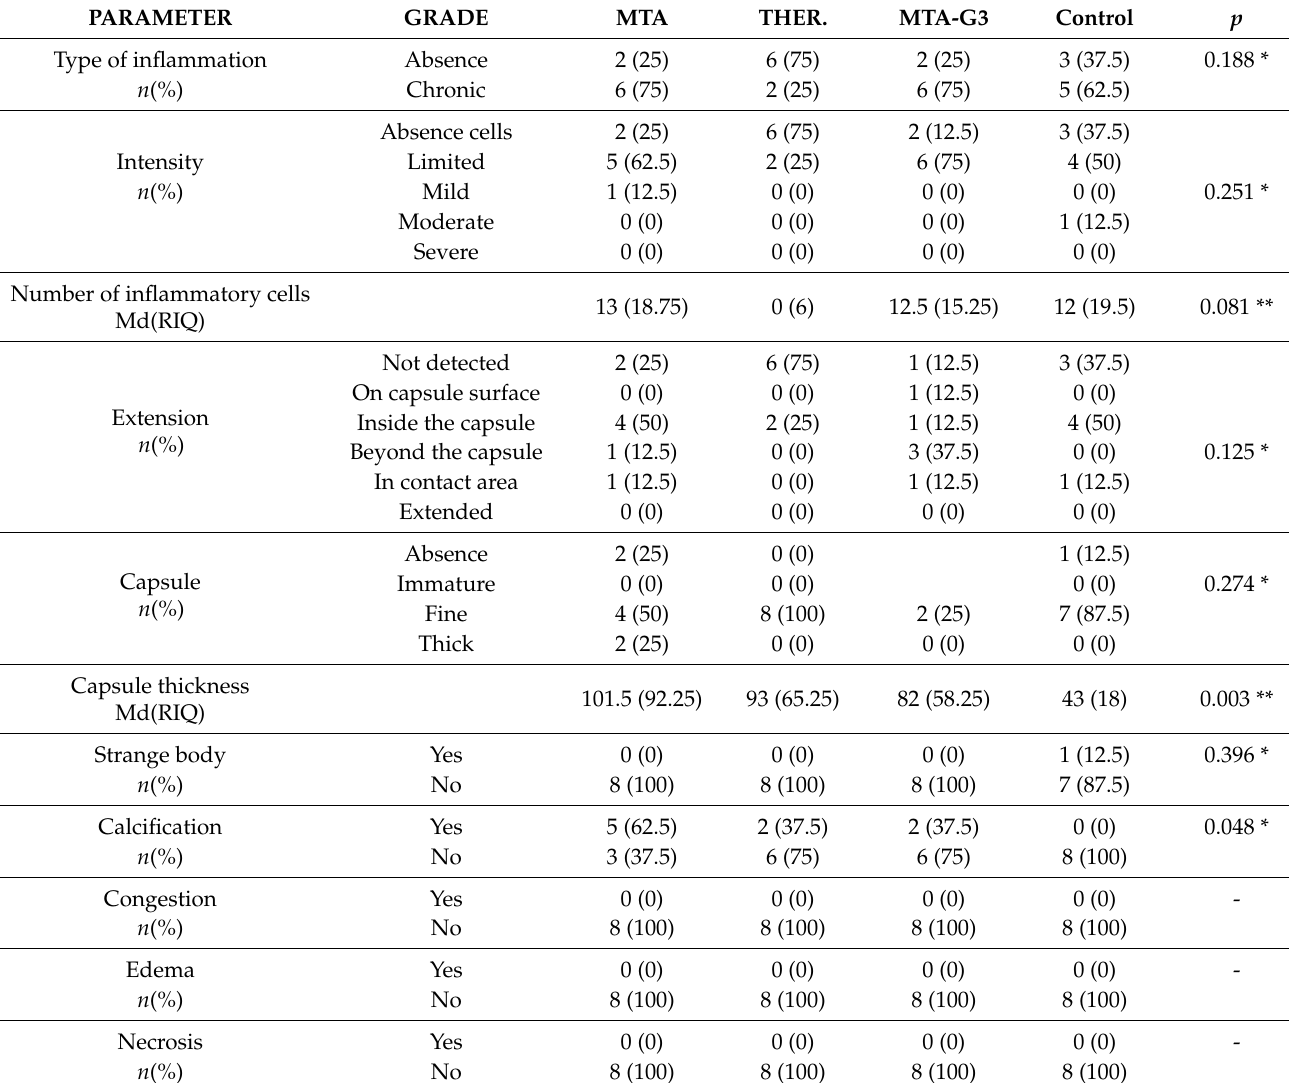
Table 6. Qualitative variables MTA, Theracal and MTA-G3, 45